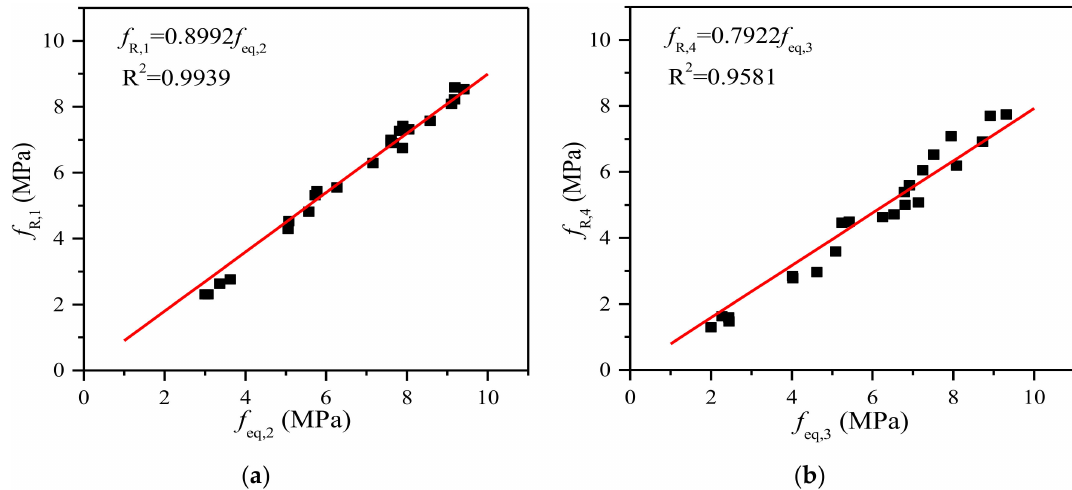
Figure 11. Relationship between equivalent and residual flexural strengths. ( a ) Relationship between f eq ,2 and f R ,1 ; ( b ) Relationship between f eq ,3 and f R ,4